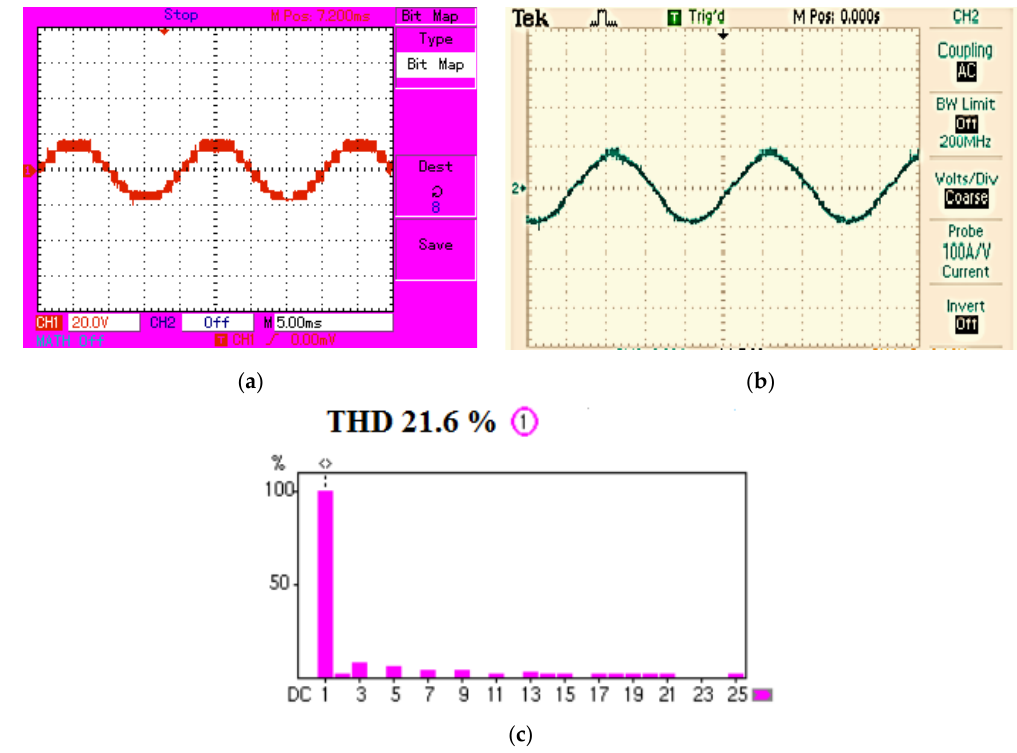
Figure 17. Experimental output waveform for the PDPWM strategy. ( a ) Voltage; ( b ) Current; ( c ) FFT plot for the output voltage.